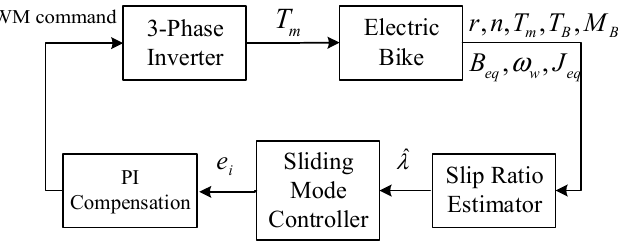
Figure 8. Simplified framework of the braking control scheme.